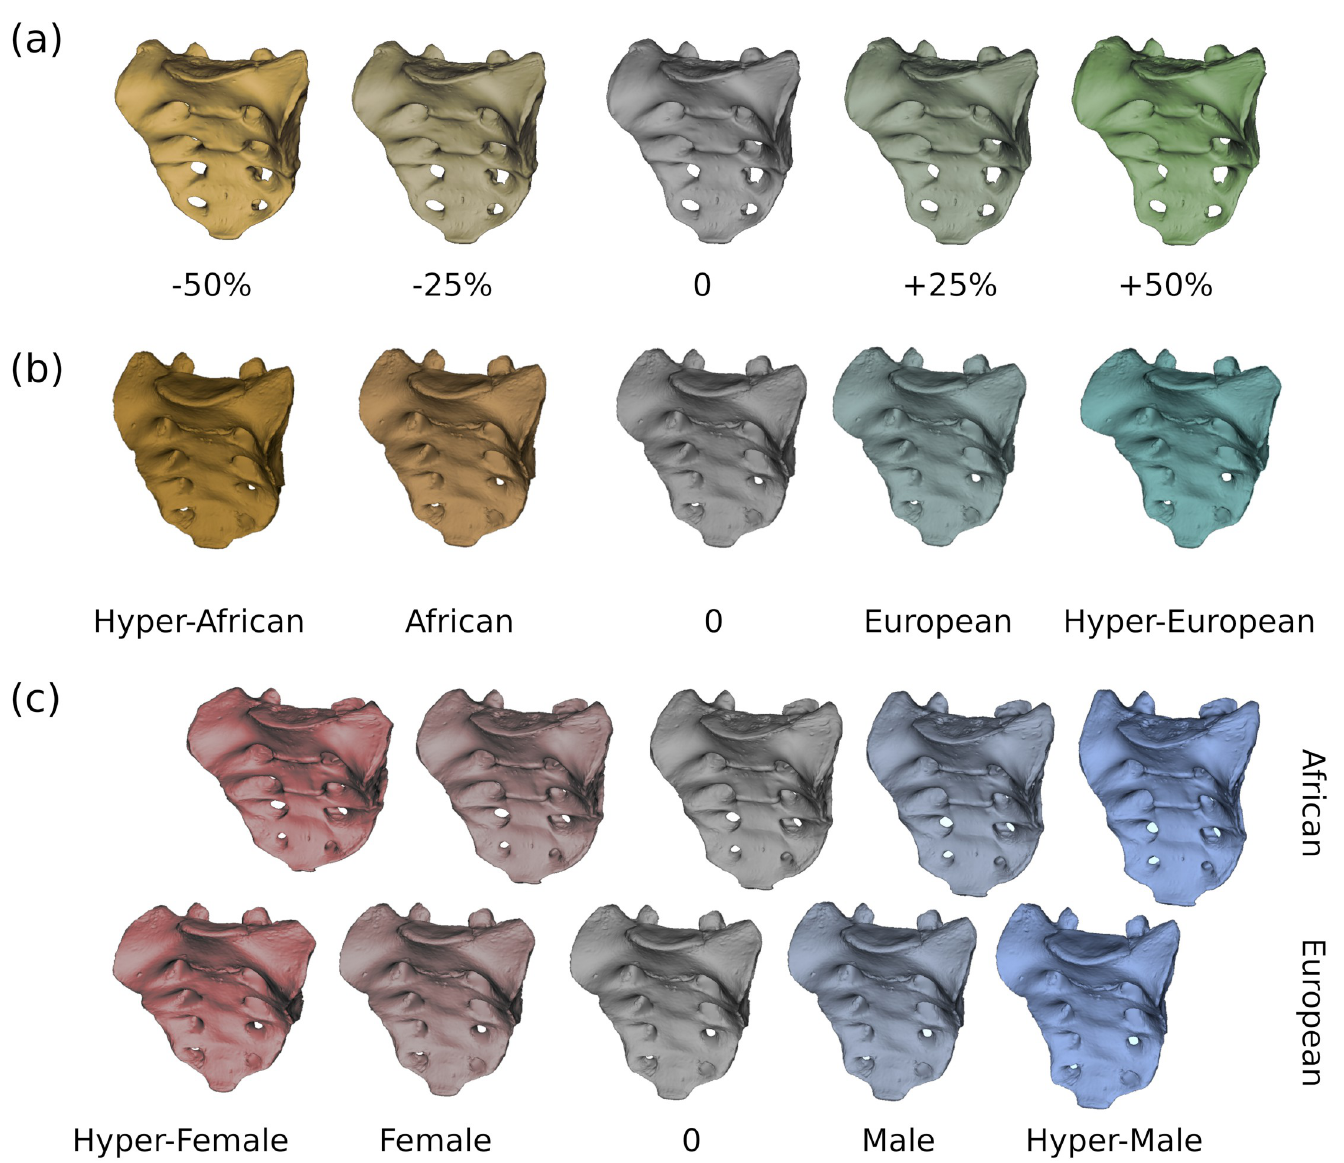
Fig 4. Variation of the sacrum shape depending on size, geographic region, and sex. (a) Multivariate regression against lnCS. The warped models are based on the regression coefficients and are shown, from left to right, at 50% and 25% smaller than average size, average size, and at 25% and 50% larger than average size. (b) Geographic group mean difference deformations between African and European subsamples (from left to right: exaggerated-African, African mean, general mean, European mean, exaggerated-European); (c) group mean difference deformations between females and males (left to right shapes: exaggerated-female, female mean, general mean, male mean, exaggerated-male). Note that the mean shapes used for group mean differences in (b) and (c) were not corrected for allometry as this is part of the variation in these